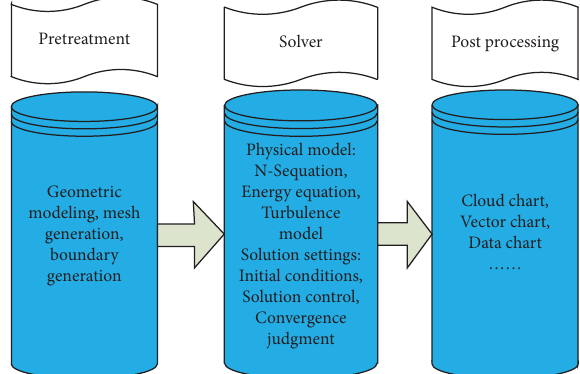
Figure 3: Technical steps and methods of CFD numerical